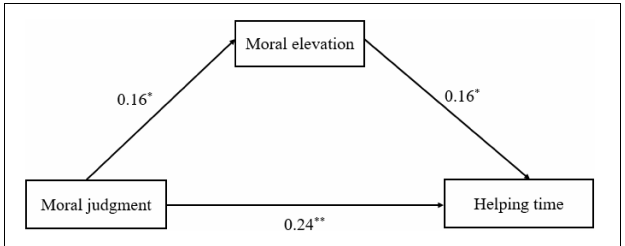
FIGURE 4 | The moderated mediation models for men. ∗ p < 0.05, ∗∗ p <